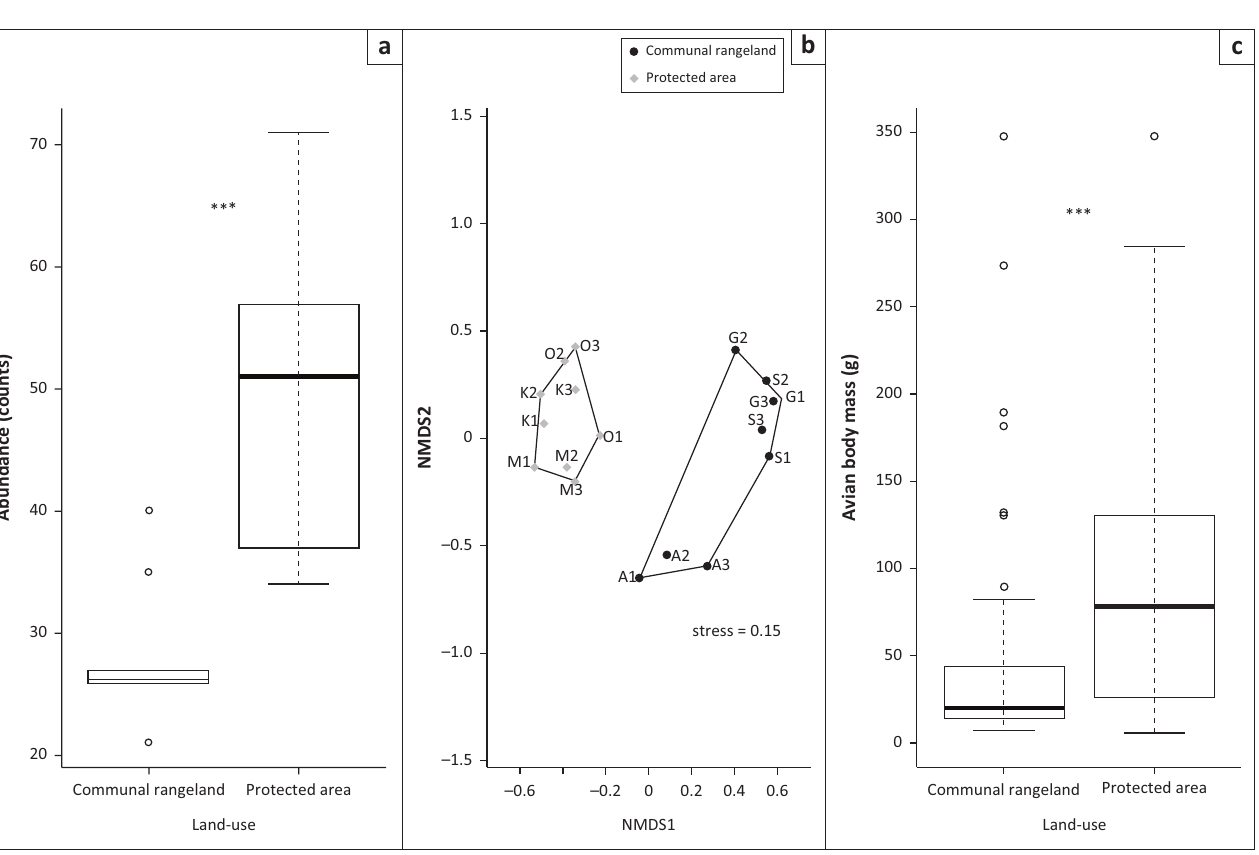
FIGURE 2: (a) Boxplot comparing the abundances (counts) of birds per transect survey between land-use types (protected areas vs. communal rangelands). (b) Non-metric multi-dimensional scaling ordination plot of bird assemblages in different land-use types. The stress value for the ordination was 0.15, indicating that the projected distances in the ordination diagram were reliable. Each point represents one transect; different letters represent different sites. Numbers represent the three different transects of each site. (c) Boxplot comparing median body masses of birds recorded per transect between land-use types. Median body mass was calculated by pooling both bird surveys of each transect.